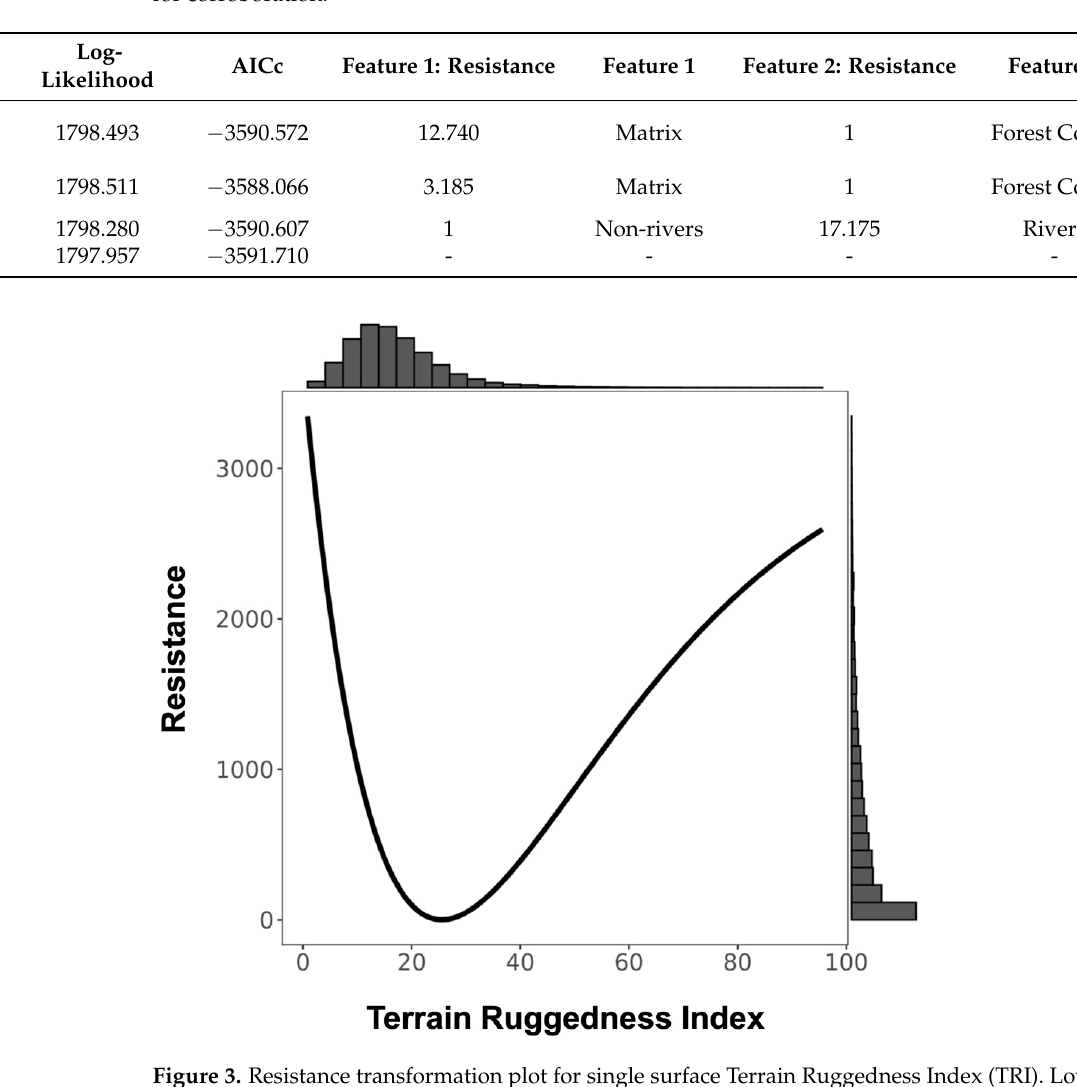
Figure 4. Resistance transformation plot for single surface canopy height. Resistance to ruffed lemur movement was greater in areas with canopy cover under 5 m.